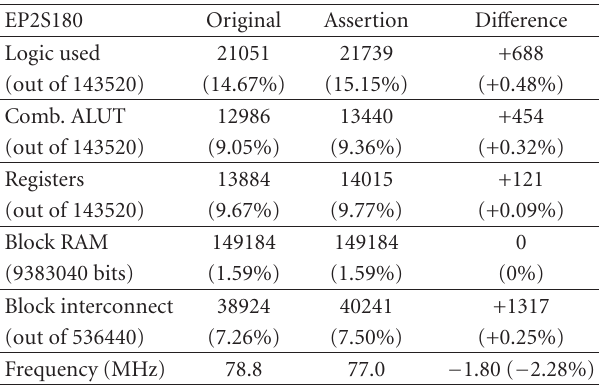
Table 7: DES hang-detection